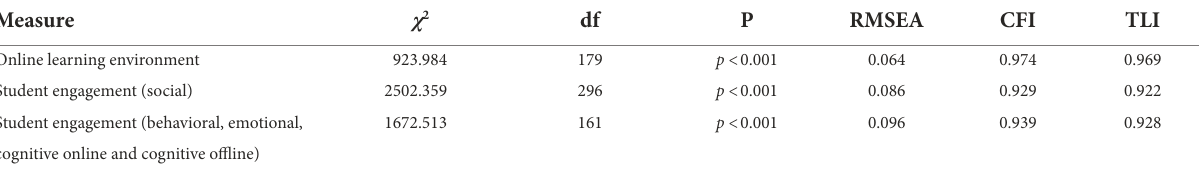
TABLE 4 Construct